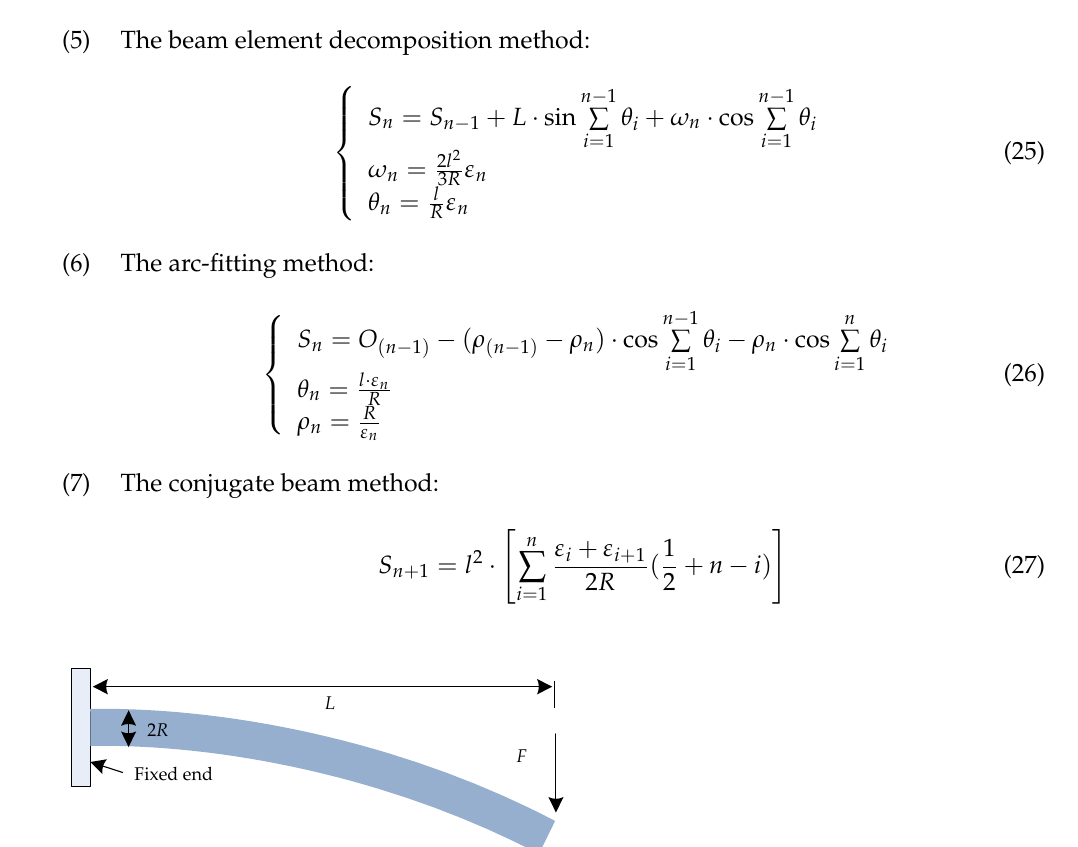
Figure 12. Schematic diagram of cantilever structure under force ( F ).